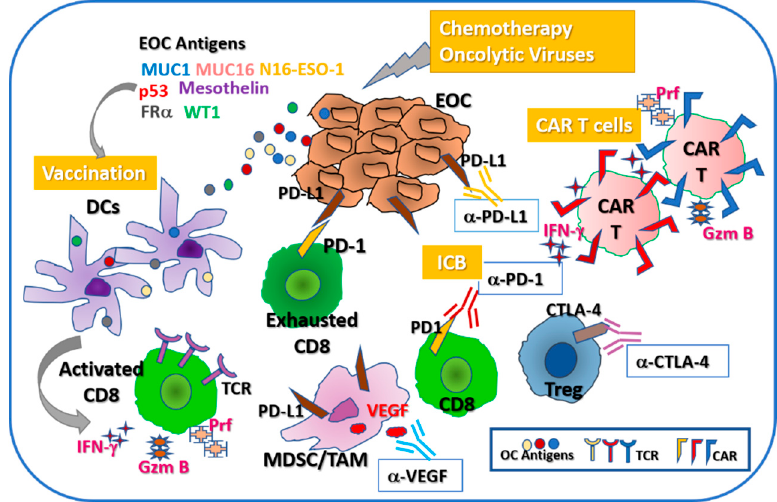
Figure 1. Diagram summarizing the main immune mechanisms targeted by immune therapy in epithelial OC. Induction of tumor cytolytic effects (via chemotherapy of oncolytic viruses) leads to the release of tumor antigens that are taken up by antigen presenting cells, primarily dendritic cells. Following intracellular processing, peptide epitopes are presented to MHC class I and class II restricted T cells. Tumor antigen primed, activated CD8 T cells express cytotoxic markers IFN-g, Gzm B and Prf, which are essential for tumor cell killing. Tumor antigen-loaded DC vaccines (using antigens such as MUC1, MUC16, NY-ESO-1, p53, mesothelin, FRa, WT1) have been developed for EOC treatment. To become effective against tumor cells, the tumor antigen specific, activated effector